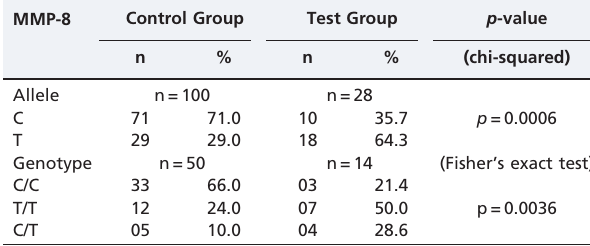
Table 1 - The distribution of the MMP-8 alleles and genotypes in the control and test